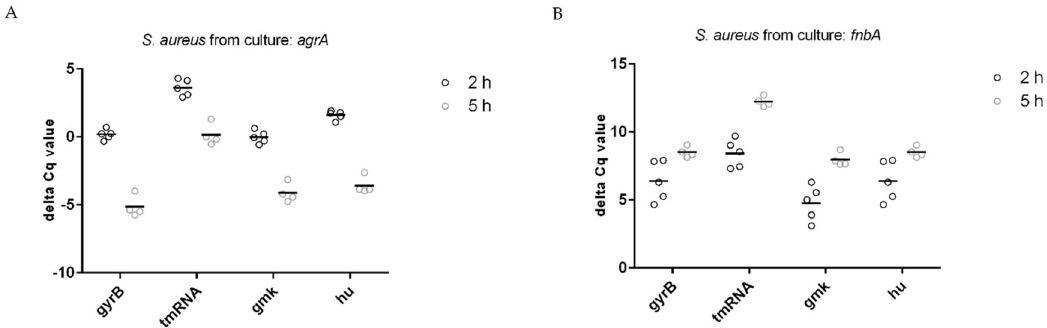
Figure 5. Variability of delta C q values of S. aureus from culture 2 h and 5 h after incubation (condi-